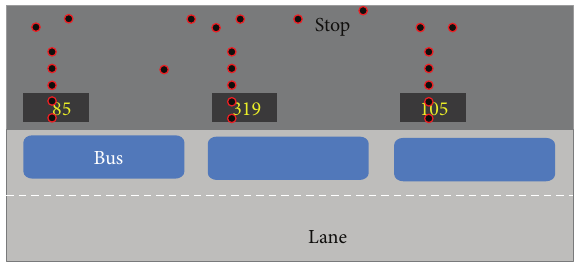
Figure 1: Passengers’ waiting process at bus